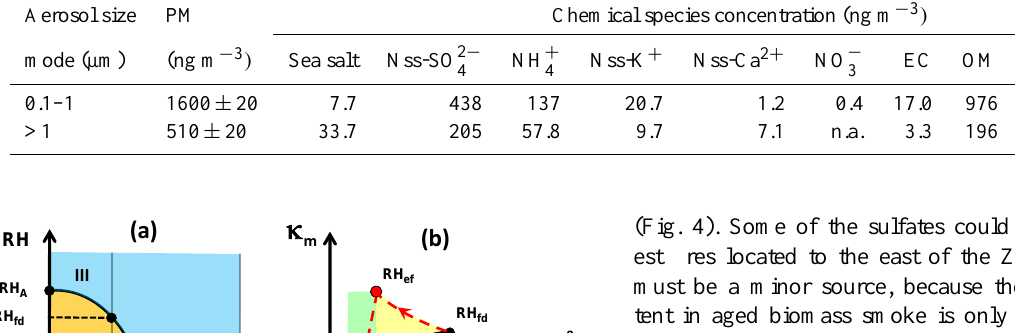
Table 2. Reconstructed particulate matter (PM) concentrations in the accumulation (0.1–1µm) and coarse (>1µm) size modes. The uncer- tainty (1 standard deviation) of the ion analysis is ∼ 10% for anions and cations. For carbonaceous material the uncertainties arise from standard instrumental error of the SunSet instrument and the assumptions used, and are estimated overall to be ∼ 30%. Aerosol size